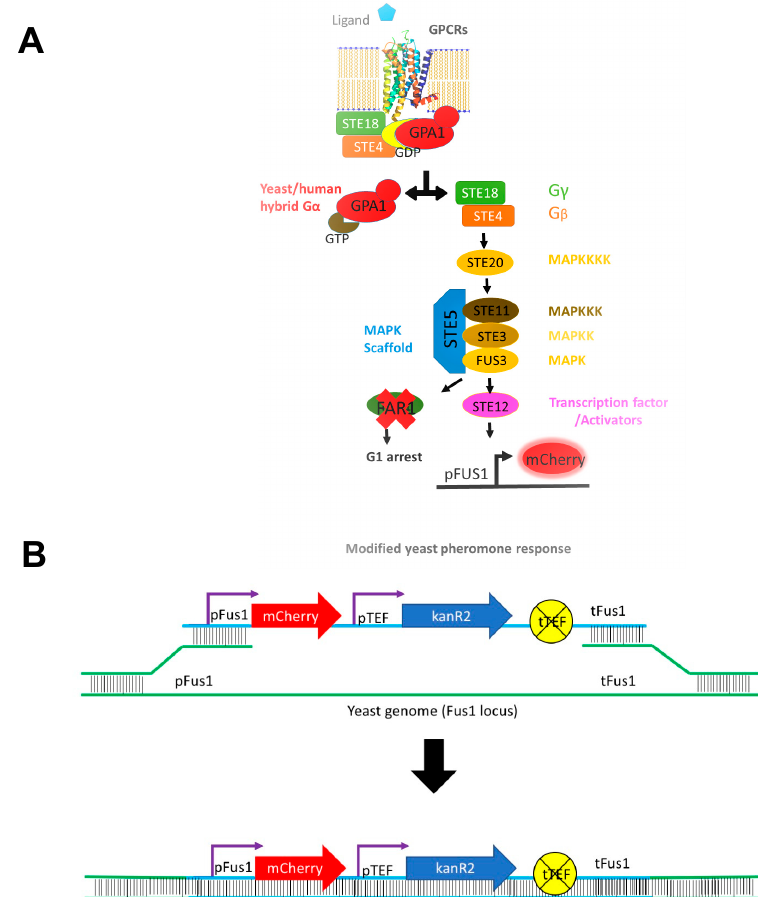
Figure 1. ( A ) Schematic of G-protein coupled receptors (GPCR)-mediated mitogen-activated protein kinase (MAPK) signaling cascade in yeast. In this engineered pheromone response signaling pathway, cells express a yeast/human chimeric G α protein to enable human GPCRs to couple with the yeast signaling pathway. Upon activation of downstream signaling, cells express mCherry fluorescent protein, which acts as an indirect measure of receptor activation. ( B ) Diagram represents homologous recombination approach used to include the mCherry gene along with the antibiotic resistance gene for clone selection within the Fus1 locus of yeast strains.